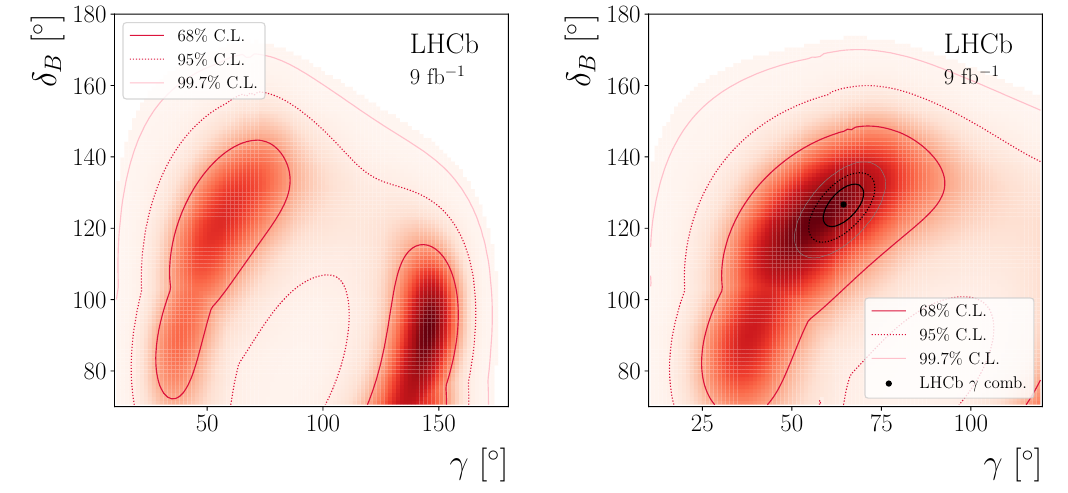
Figure 5 . Confidence regions of the strong phase, δ B versus the unitarity triangle angle, γ shows (left) two solutions, one of which is shown (right) to be consistent with the 2021 γ combination result [33] whose confidence intervals are